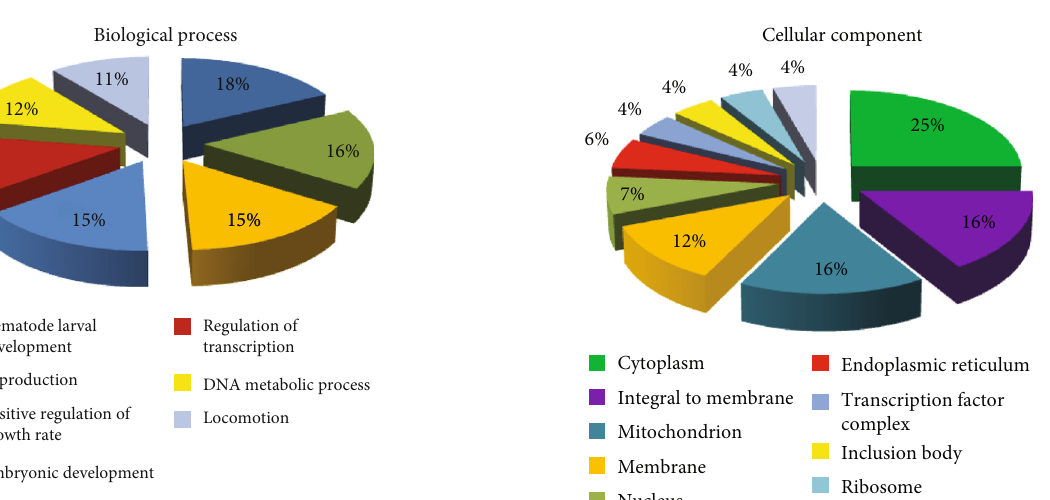
Figure 8: Gene Ontology (GO) distributions for reniform nematode genomic sequences as determined by Blast2GO and grouped by biological process for the REPLI-g library.